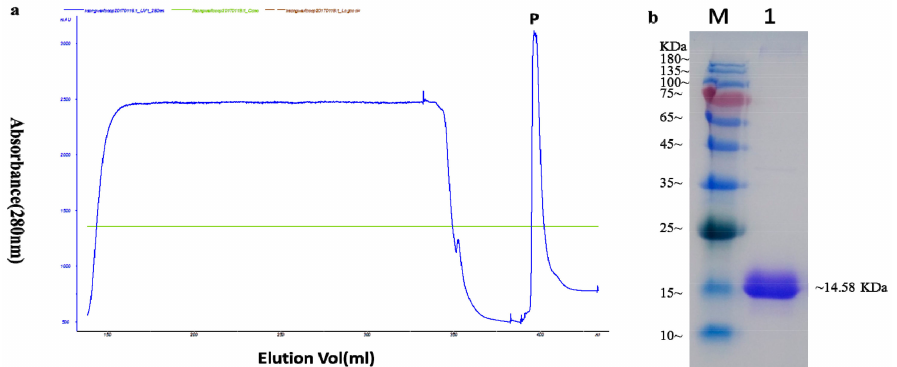
Figure 2. Purification of recombinant FocCP1 protein from Pichia pastoris cells via an ÄKTA Protein Purifier System. ( a ) The peak of separation and purification of FocCP1 protein under 280 nm ultraviolet (UV) light. Recombinant FocCP1 protein in fermentation filtrate was collected through a 5 mL His-Trap HP column at a flow rate of 2 mL / min, P: FocCP1 peak. ( b ) Sodium dodecyl sulfate polyacrylamide gel electrophoresis (SDS-PAGE) analysis of the purified recombinant protein. FocCP1 showed a single band with Coomassie Brilliant Blue R-250 staining, M: protein molecular weight marker, 1: